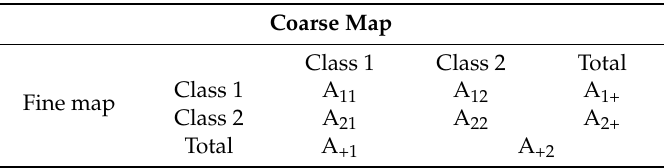
Table 5. An example of a similarity